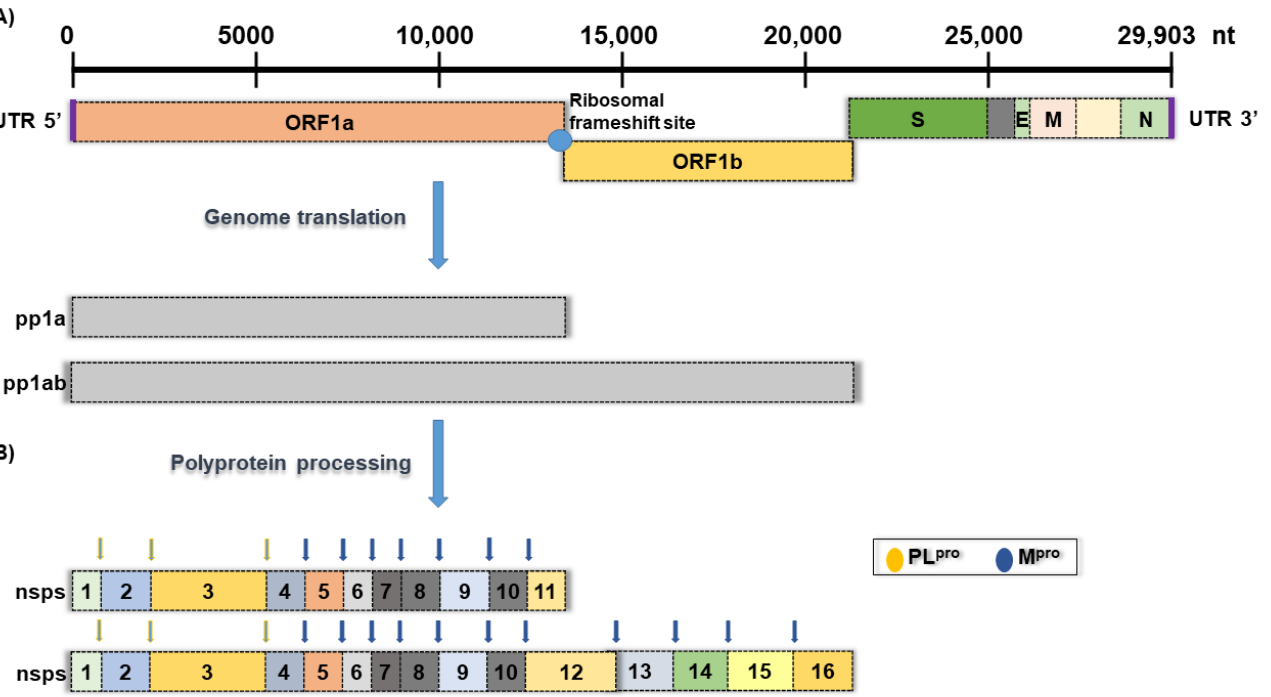
Figure 1. Schematic presentation of the SARS-CoV-2 genome organization. ( A ) Full-length genomic RNA (29,903 nt) that serves as an mRNA, containing ORF1a, ORF1b, and nine subgenomic RNAs. ( B ) Schematic representation of non-structural polyprotein cleavage sites. There are two viral proteases: a papain-like protease (PL pro ) cleaves virus nonstructural polyprotein at three sites, and the other main protease (M pro ) recognizes and cleaves the virus non-structural polyprotein at 11 sites.